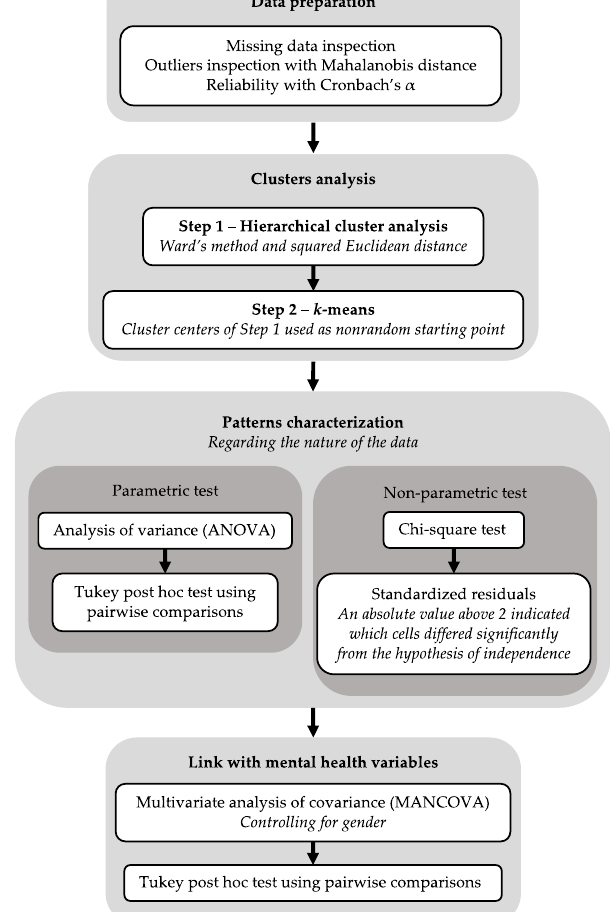
Figure 1. Flowchart of analysis plan.